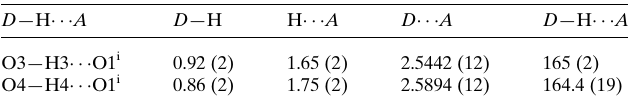
Table 2 Selected geometric parameters (A˚ , (cid:4) ) for 2